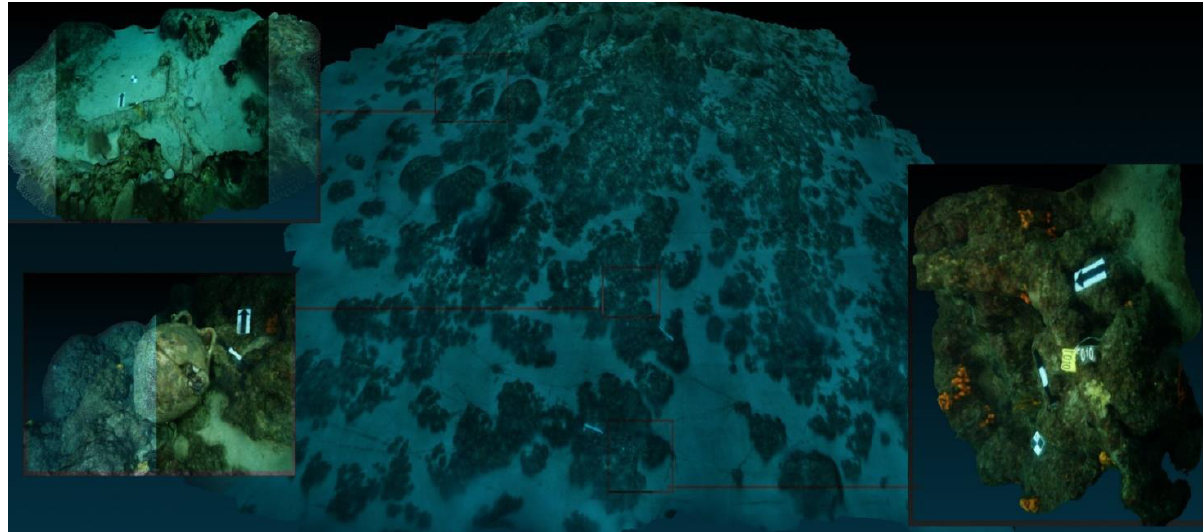
Figure 12: 3D reconstruction of Glaros underwater archaeological site (©IENAE